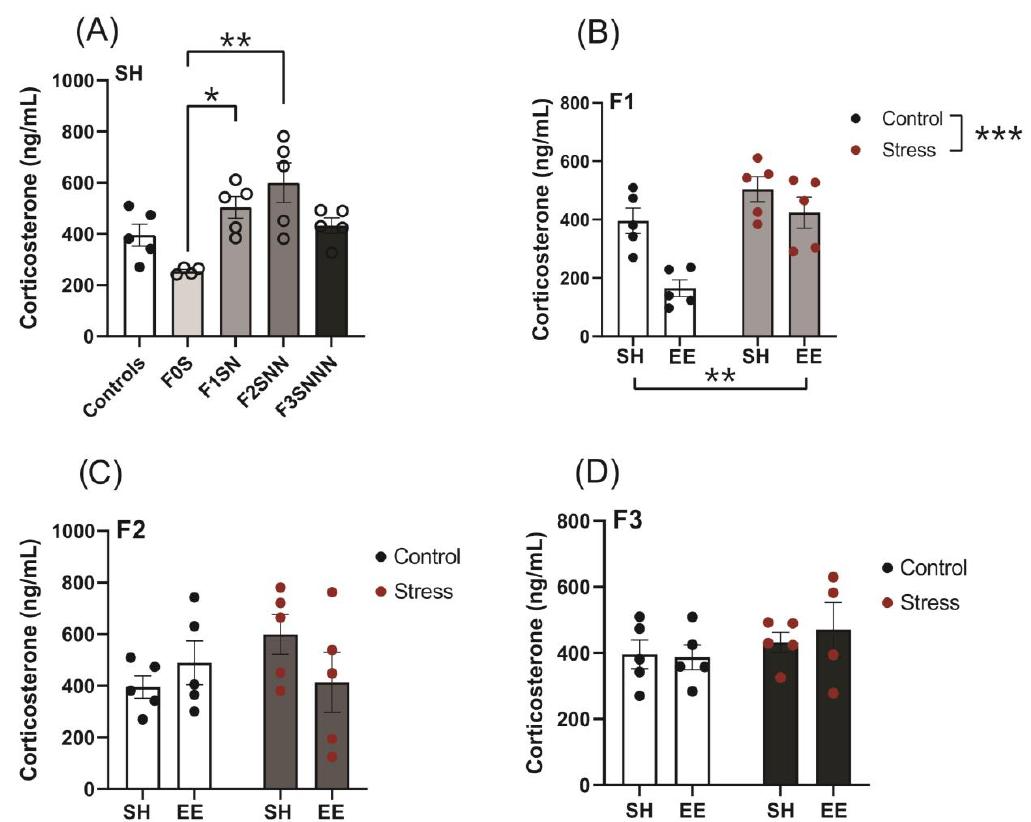
Figure 5. Elevated CORT concentrations in the F1 and F2 stressed offspring despite enrichment therapy. ( A ) Plasma CORT levels in the F0–F3 stressed and control animals. Effects of housing and treatment on the ( B ) F1, ( C ) F2, and ( D ) F3 generations. Asterisks indicate significance: <0.05 (*); <0.002 (**); <0.001 (***). Data are compared to F0N, mean ± SEM. Ordinary one-way ANOVA ( A ) and two-way ANOVA ( B – D ) analyses were used. N = 4–5 per group. SH = standard housing; EE = enriched housing; F = filial generation; S = stressed; N = nonstressed.